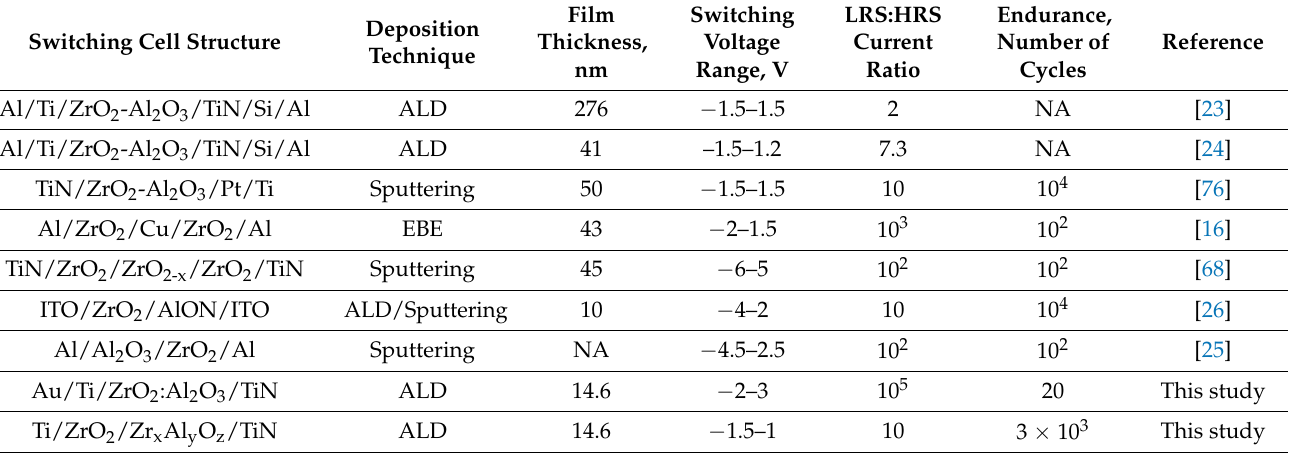
Table 3. Comparison of RS stacks containing ZrO 2 or different combinations of ZrO 2 with Al 2 O 3 as RS media. Given are also the film growth techniques, thicknesses, and maximum switching voltage range from negative to positive polarity in relation to bottom electrode. For low and high resistivity state ratios as well as amounts of endurance cycles, order of magnitudes implied in the reference studies are indicated. Data not revealed in the reference papers, and thus not available, are denoted by